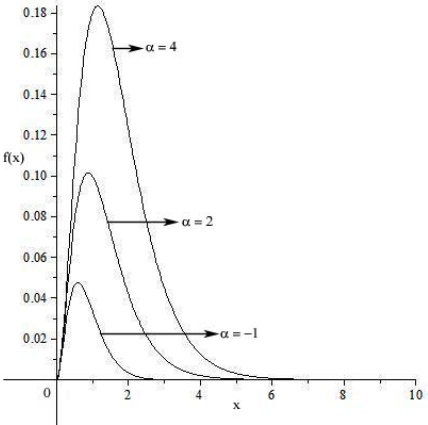
Figure 1 The graph of the density function for (cid:13) =2, b=3, and for various values of